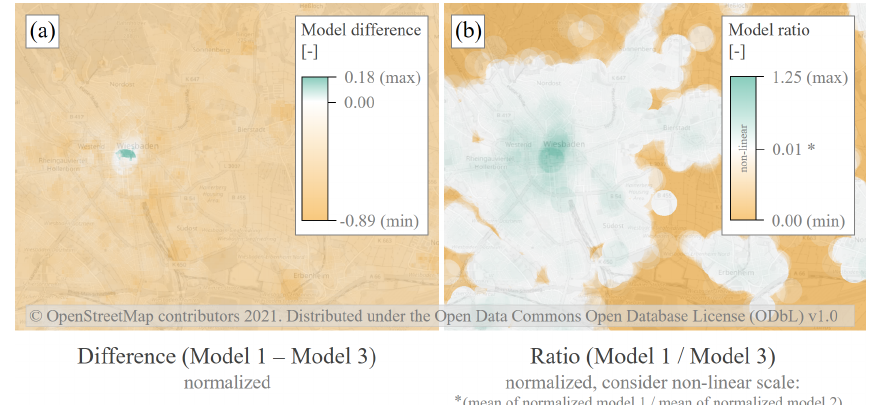
Figure 5. Difference and Ratio of model 1 and model